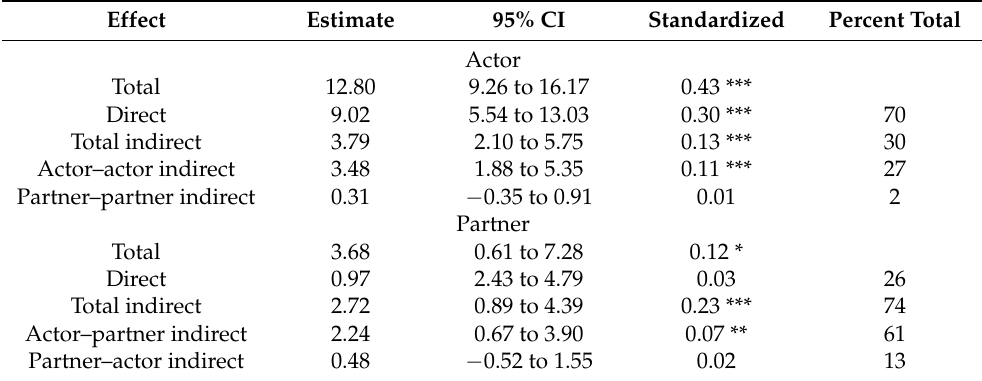
Table 6. Effects of self-perceived delegated DC mediation.